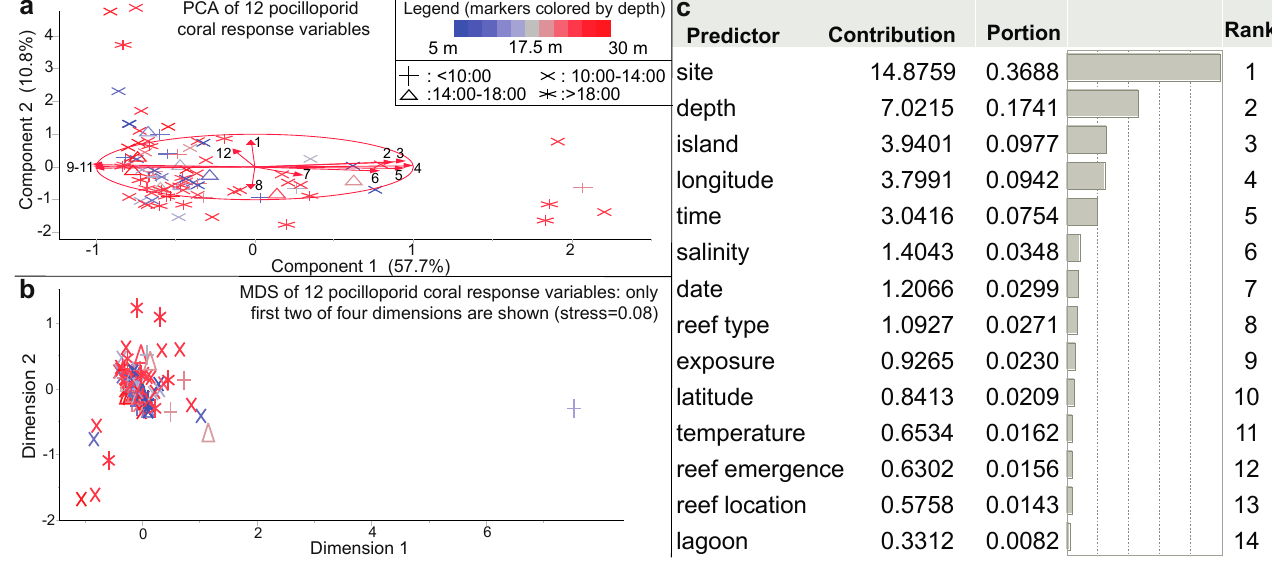
Figure 4. Multivariate analysis of the coral physiological data and a predictor screen of the coral health index (CHI). Both principal components analysis (PCA; on correlations; [ a ]) and multi-dimensional scaling (MDS; on standardized data; [ b ]) were undertaken with the 12-physiological response variable coral dataset ( n = 110 samples). The biplot rays in ( a ) are as follows: colony length (1), Symbiodiniaceae (Sym) rbcL (2), Sym zifl1l (3), host coral lectin (4), host coral ca (5), host coral gfp - cp (6), RNA/DNA ratio (7), mean coral color score (8), Sym hsp90 (9), host coral cu-zn-sod (10), Sym ubiq-lig (11), and Sym genome copy proportion (GCP; 12). The legend in ( a ) extends to ( b ). In the predictor screen of CHI ( c ), a bootstrap forest model with 100 random trees was used to estimate the contribution of each of the 14 environmental parameters to the CHI.